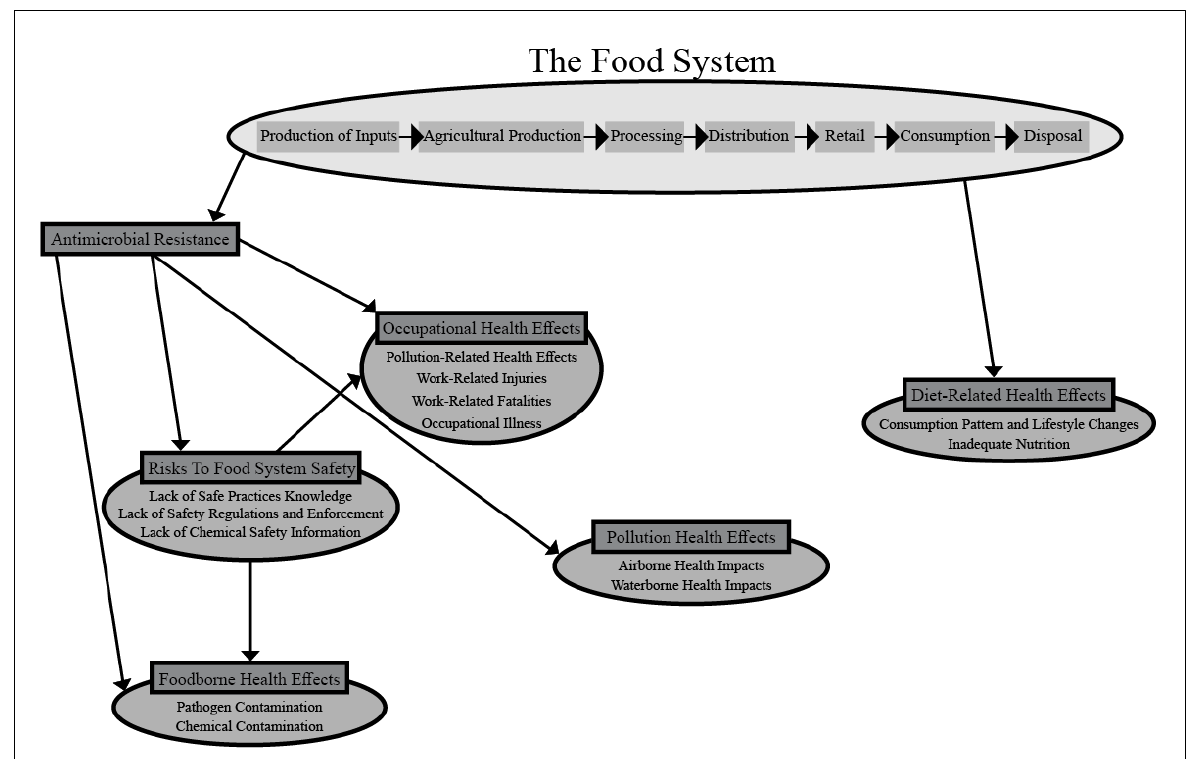
Figure B3. Human Health Outcomes Map of the U.S. Food System, Outcomes Derived from